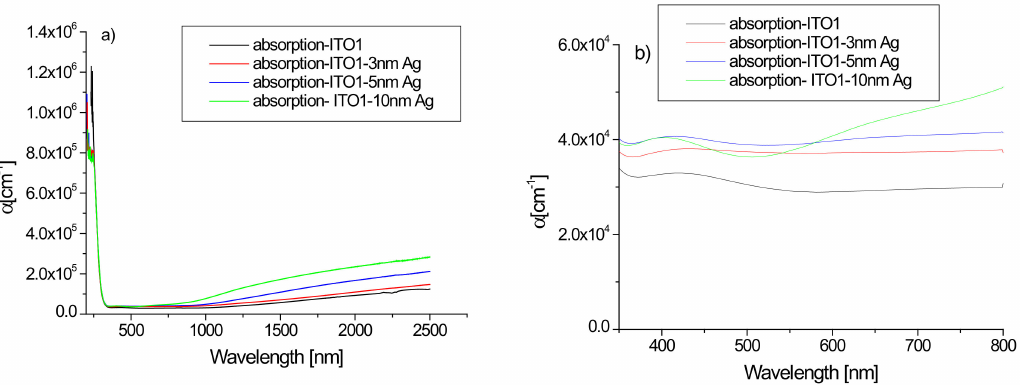
Figure 5. ( a , b ) Absorption spectra of ITO1/glass and Ag/ITO1/glass layers in the region 180–2500 nm ( a ) and in the visible region ( b